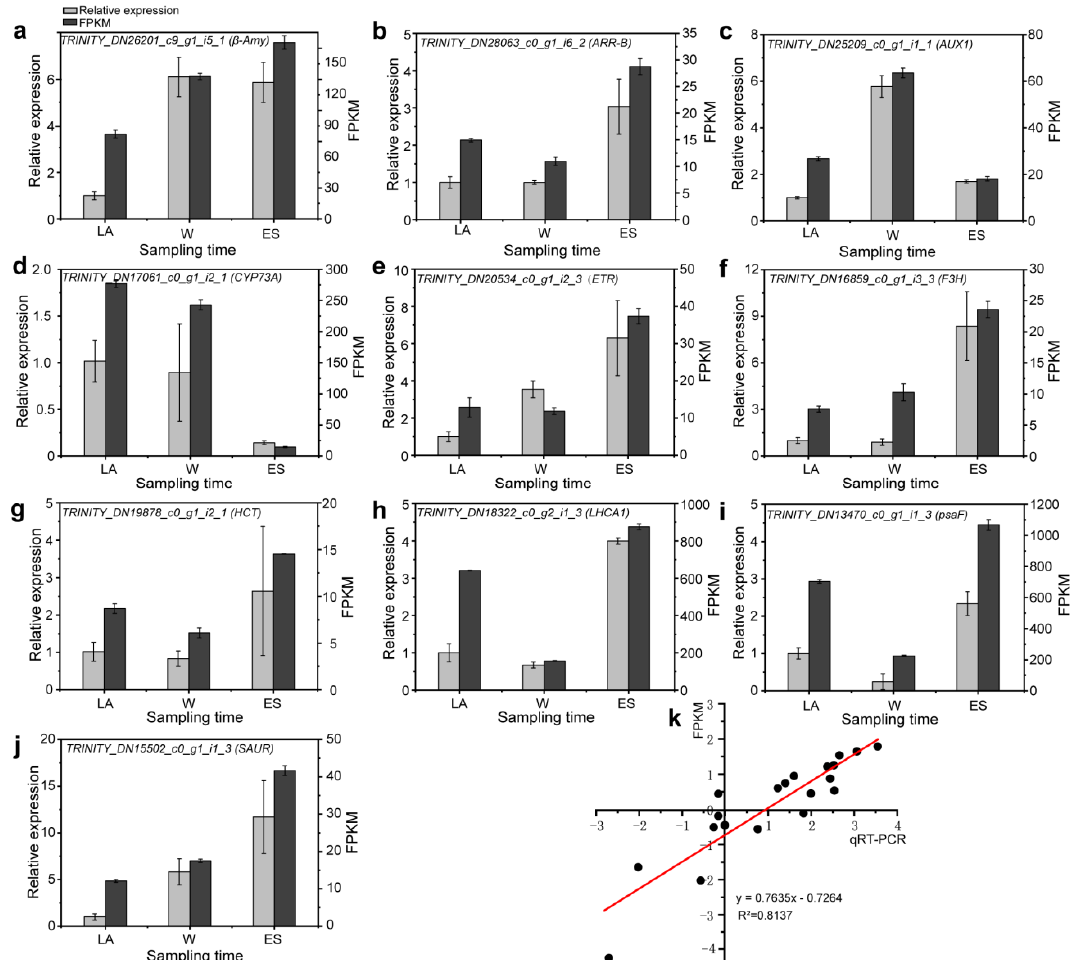
Figure 8. Expression of C. fortunei genes in response to cold winters as determined by quantitative real-time polymerase chain reaction (qRT-PCR). Differentially expressed unigenes involved in starch and sucrose metabolism ( a ), flavonoid/phenylpropanoid biosynthesis ( d , f , g ) , plant hormone signal transduction ( b , c , e , j ), and photosynthesis-related ( h , i ) pathways. The x -axis represents samples (i.e., ES, early spring; LA, late autumn; and W, winter), the y -axis represents FPKM or unigene relative expression level, and each value is the mean ± standard deviation (n = 3). FPKM, fragments per kilobase of exon per million fragments mapped. Gene abbreviations are as follows: β -Amy, beta-amylase; ARR-B, two-component response regulator ARR-B family; AUX1, auxin influx carrier; CYP73A, trans-cinnamate 4-monooxygenase; ETR, ethylene receptor; F3H, naringenin 3-dioxygenase; HCT, shikimate O-hydroxycinnamoyltransferase; LHCA1, light-harvesting complex I chlorophyll a/b binding protein 1; psaF, photosystem I subunit III; SAUR, small-auxin-up-RNA. ( k ) Linear fitting of qRT-PCR data and FPKM data were performed after normalizing their row data with LA data as a reference, respectively. The x -axis represents qRT-PCR data, and the y -axis represents FPKM data.